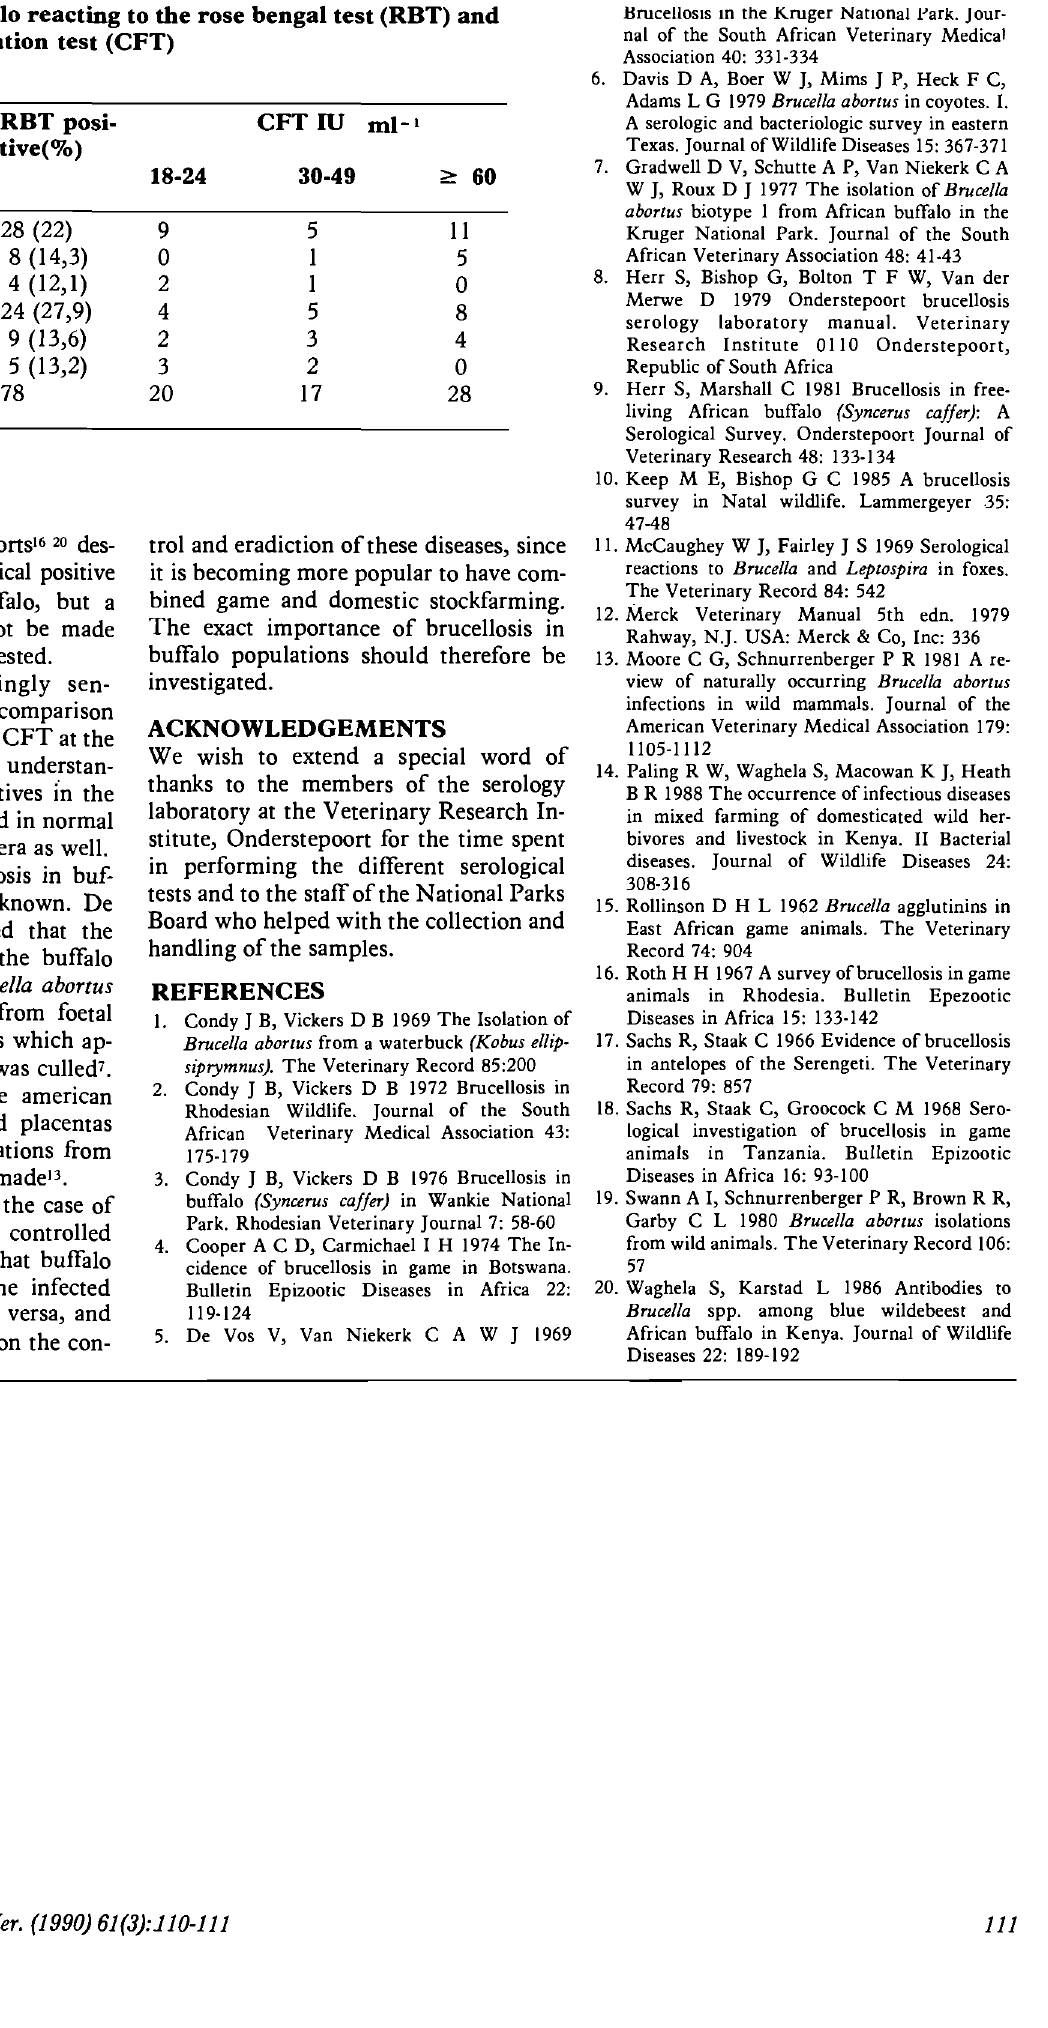
Table I: Number of buffalo reacting to the rose bengal test (RBT) and comple ment fixation test